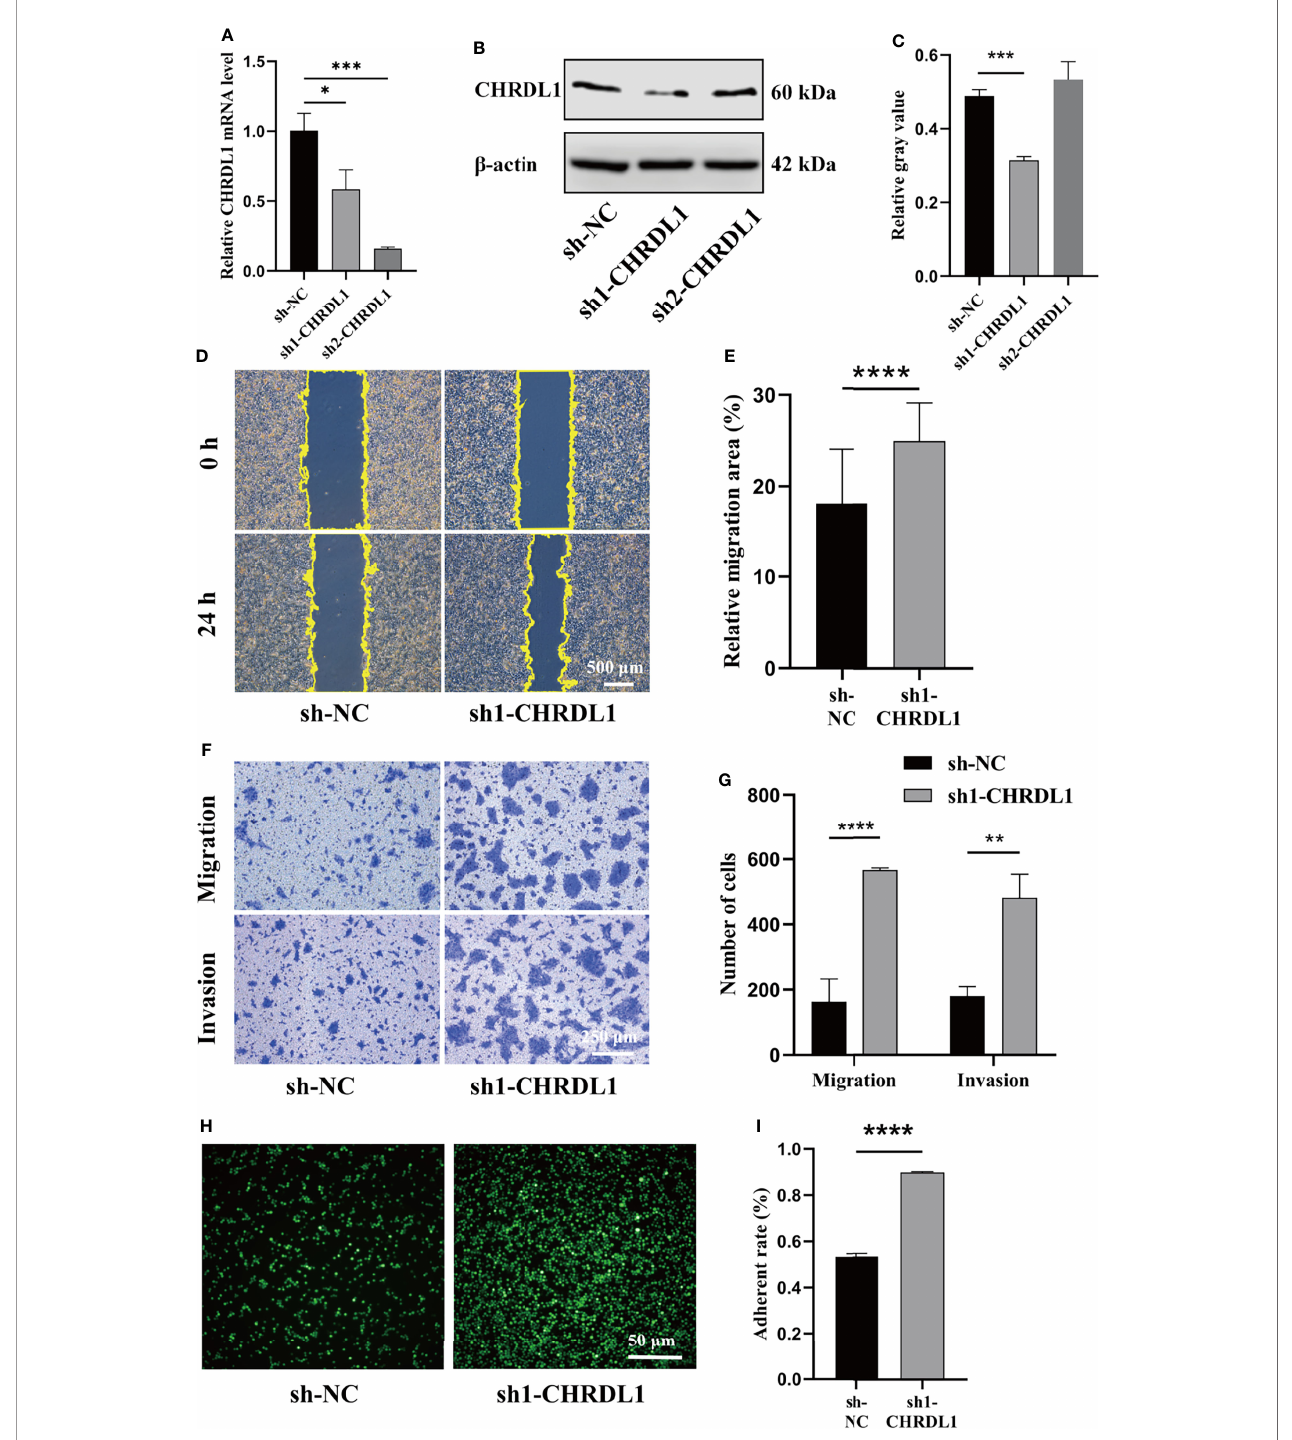
FIGURE 3 | CHRDL1 knockdown promotes CAL27 cell migration, invasion, and adhesion. (A) Relative mRNA expression of CHRDL1 in CAL27 cells after lentivirus transfection. (B, C) CHRDL1 protein expression in CAL27 cells after lentivirus transfection was evaluated by Western blot and quantitatively analyzed. (D, E) Representative images of wound-healing assays of transfected CAL27 cells at 0 and 24 h and statistical analyses of each group. (F, G) Migration and invasion assays of transfected CAL27 cells. Representative images of cell migration and invasion in each group are shown in (F) . Statistical analyses of cell migration and invasion are shown in (G) . (H, I) Cell adhesion assay of transfected CAL27 cells. Representative fl uorescence images of each group (H) and statistical analyses of the adherence rate (I) . Error bars represent the standard deviation. * p < 0.05, ** p < 0.01, *** p < 0.001, **** p <